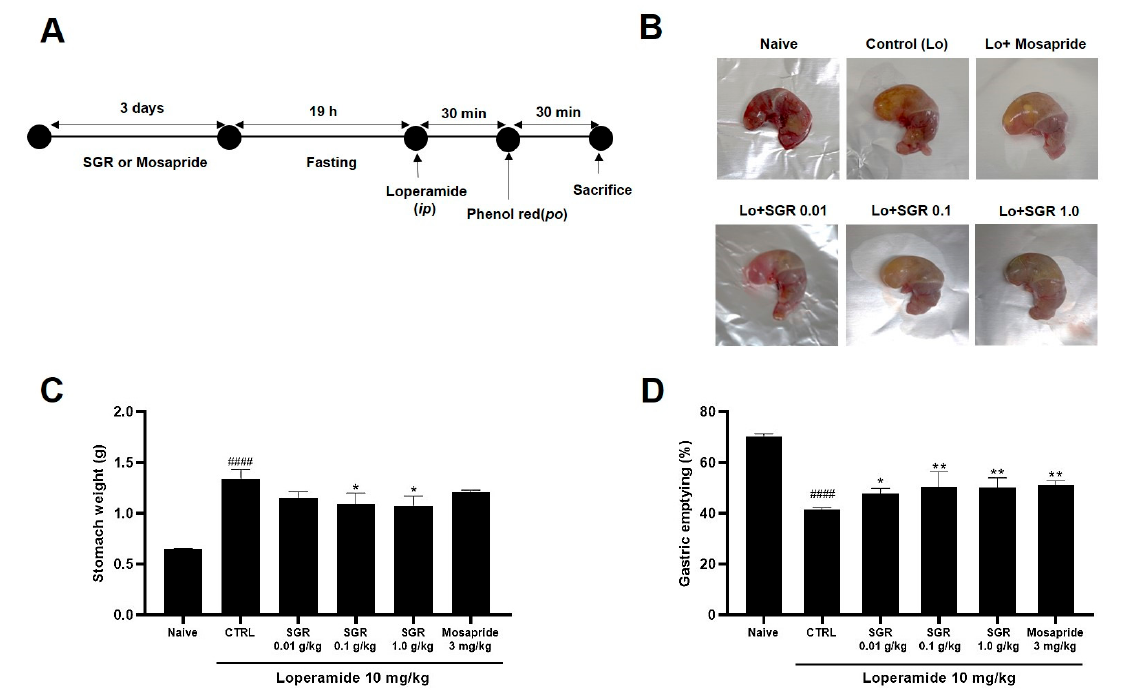
Figure 7. Effects of SGR extract on delayed gastric emptying. ( A ) summary of the experimental schedule; ( B ) visualization; ( C ) stomach weight; ( D ) gastric emptying. Naïve ( n = 15). CTRL ( n = 15). SGR 0.01 g ( n = 14). SGR 0.1 g ( n = 15). SGR 1 g ( n = 14). Mosapride ( n = 13). Bars represent mean ± standard error. * p < 0.05, ** p < 0.01 for the Control group; #### p < 0.0001 for the loperamide group. CTRL: Control. SGR: Smilacis Glabrae Rhixoma.